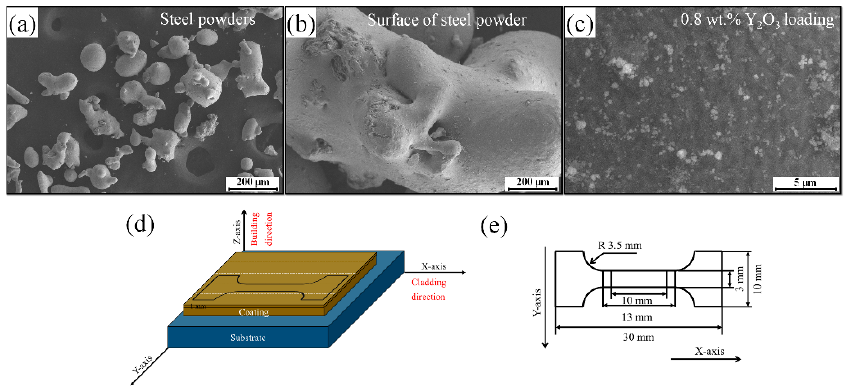
Figure 1. ( a ) Macro view of 14CrSiMnV steel powder, ( b ) Morphology of 14CrSiMnV powder, ( c ) Surface of 14CrSiMnV powder covered with Y 2 O 3 nanoparticles, ( d ) Location of tensile specimens extracted from the coatings, ( e ) schematic illustration of tensile specimens.